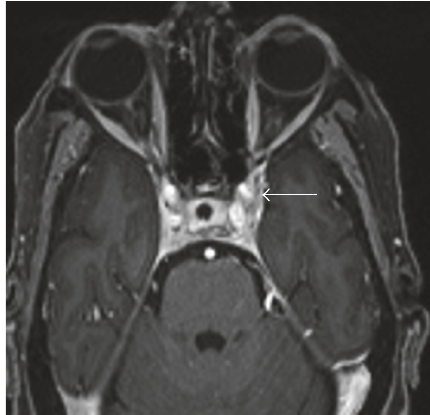
Figure 6: Axial contrast enhanced T1 weighted image of the brain showing increased outward convexity due to enhancing lesion in the left cavernous sinus (arrow) encasing the left internal carotid artery; however, it remained